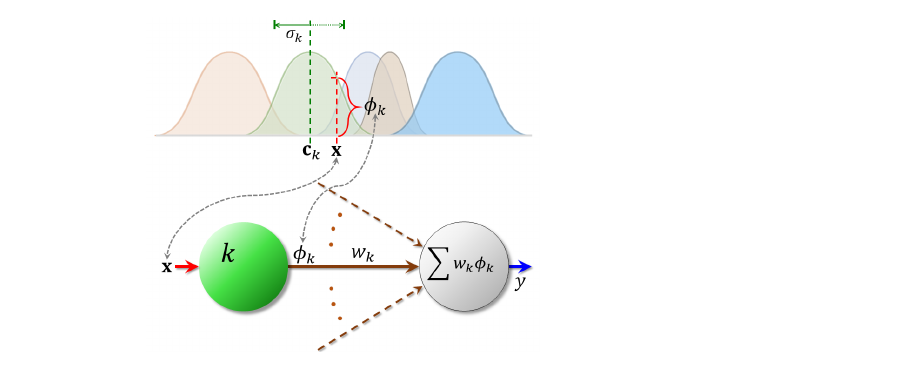
Figure 7. Radial Basis Function. Shown are a hidden neuron (green) and the output neuron